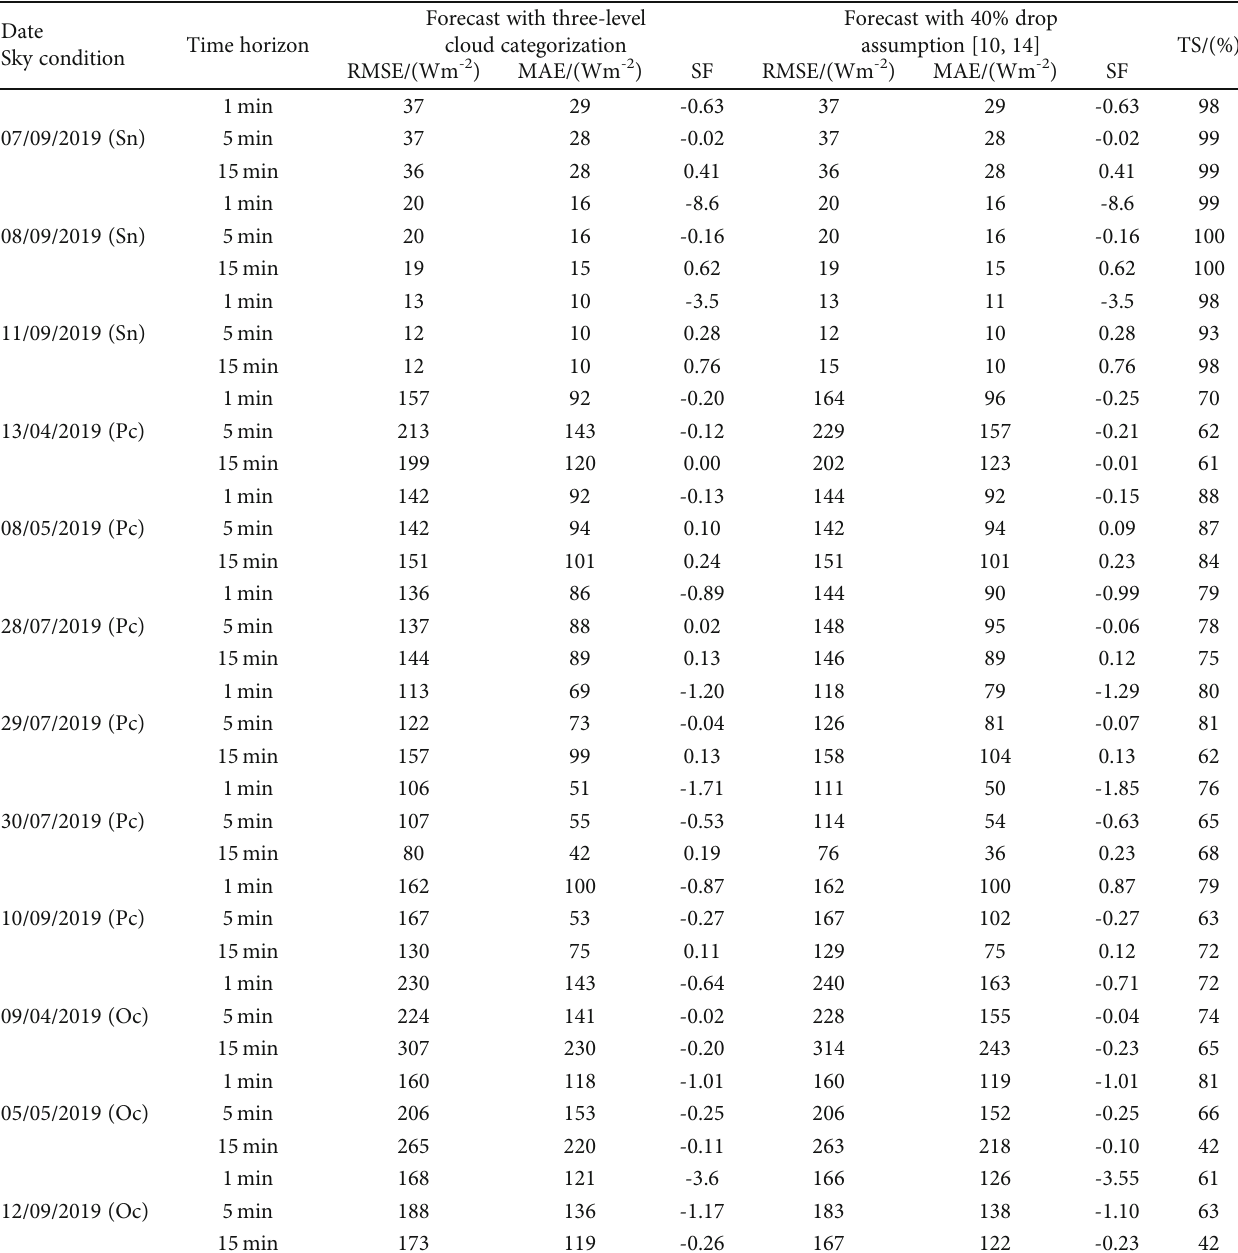
Table 3: RMSE, MAE, and TS for irradiance forecasts and irradiance forecasts at location 1 (onsite forecasting) with three-level irradiance drop percentages and with 40% irradiance drop assumption (Sn: sunny; Oc: overcast; Pc: partially